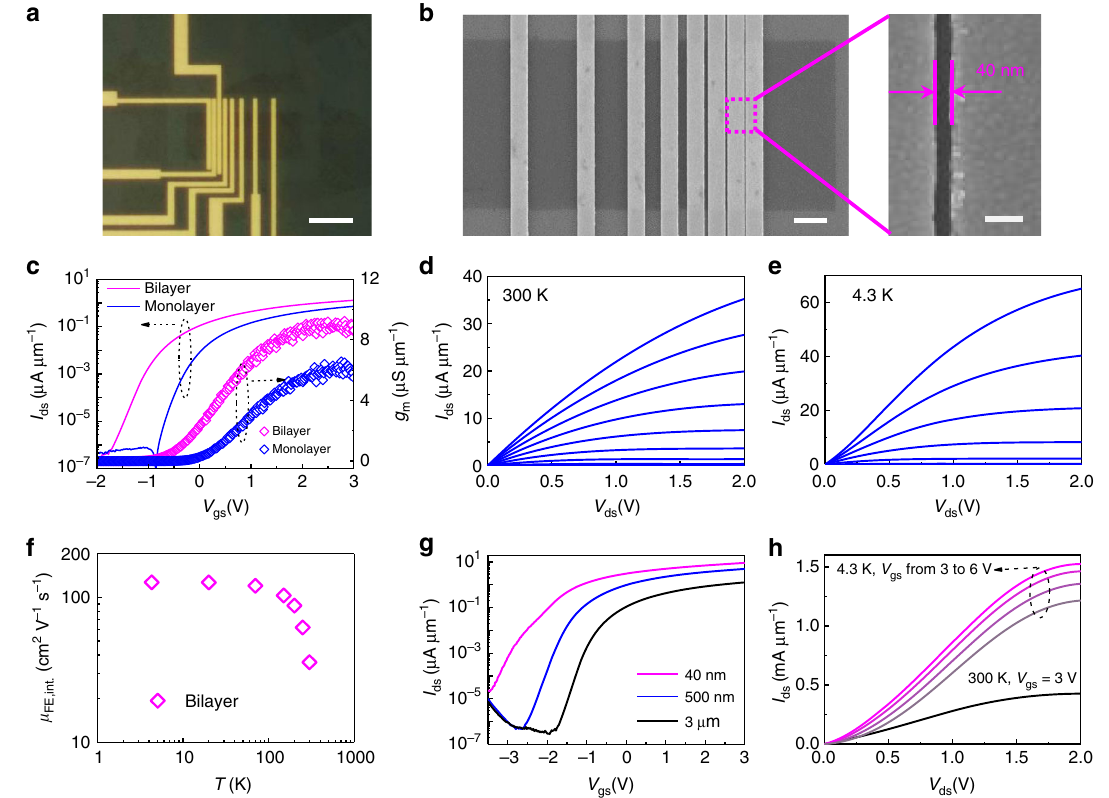
Fig. 3 DC electrical characterization of back-gated bilayer MoS 2 transistors at room temperature and low temperatures. a Optical micrograph of back-gated MoS 2 transistors with different channel lengths. Scale bar is 10 μ m. b The corresponding SEM images of the active device region and the zoom-in picture. Scale bar are 2 μ m and 100 nm, respectively. c The I ds − V gs transfer characteristics at 50 mV bias voltage and g m − V gs curves at 1 V bias voltage for the 3 μ m channel length back-gated monolayer (blue line and open diamonds, respectively) and bilayer (magenta line and open diamonds, respectively) MoS 2 transistors. d , e The I ds − V ds output characteristics of the bilayer MoS 2 transistor at 300 K and 4.3 K. The back-gate voltages vary from − 1 to 3 V with a step of 0.5 V. f The extracted intrinsic fi eld-effect mobility versus temperature of bilayer MoS 2 FETs. g The I ds − V gs transfer characteristics at 50 mV bias voltage at room temperatures for different channel lengths of 40 nm (magenta line), 500 nm (blue line), and 3 μ m (black line). h The I ds − V ds output curves at 300 K and 4.3 K for bilayer MoS 2 transistors with a channel length of 40 nm. A record I on of 1.52 mA μ m − 1 was bilayer MoS 2 RF transistors, cut-off frequencies and maximum oscillation frequencies with different gate lengths are plotted in Fig. 4f, g, respectively. Both f T and f max increase as the gate lengths decrease, and this positive scaling is bene fi ted from the